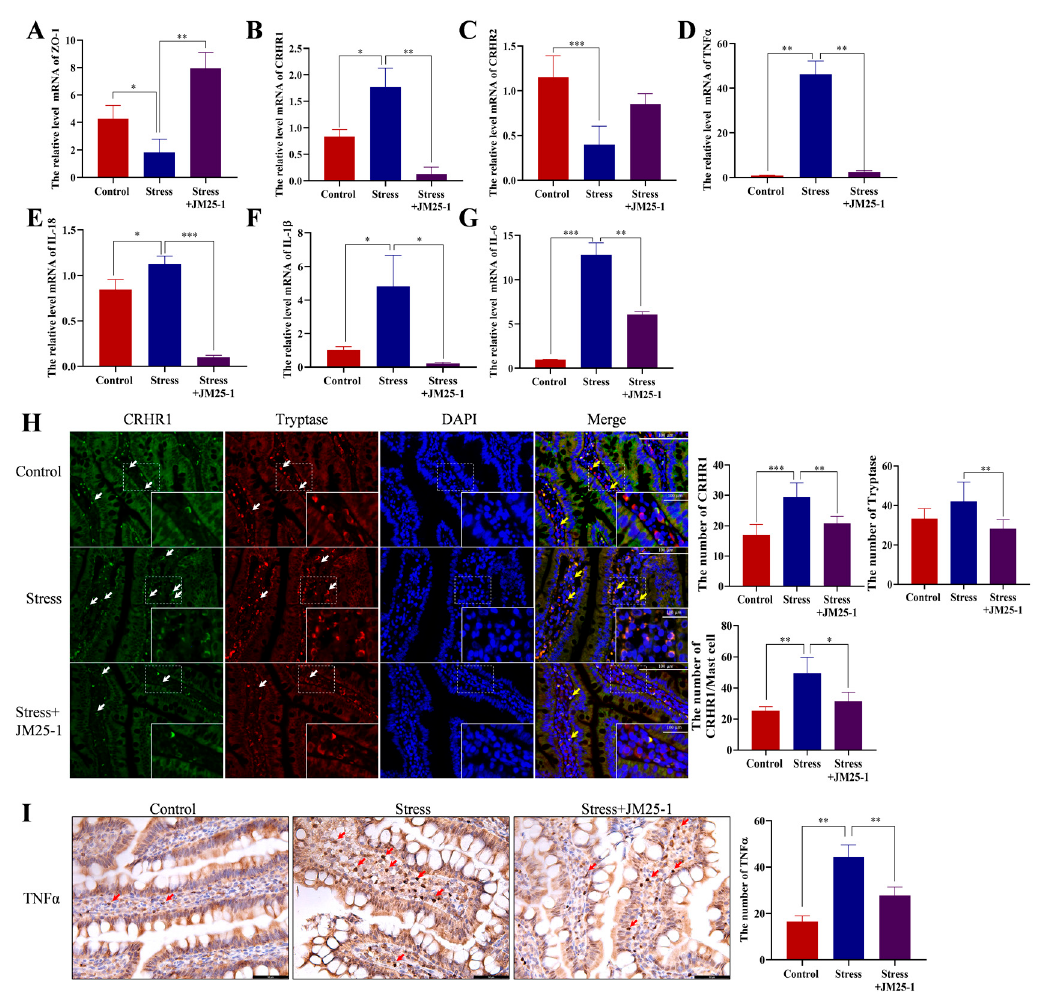
Figure 5. Effect of JM25-1 on the expression of CRH receptors and cytokines in small intestine of stress-induced rats. The relative expression of related mRNA in small intestine of stress-induced rats for ( A ) ZO-1, ( B ) CRHR1, ( C ) CRHR2, ( D ) TNF α , ( E ) IL-18, ( F ) IL-1 β and ( G ) IL-6. The data are repeated in at least three independent experiments in triplicate compared with Control group. Bars, S.D. * p ≤ 0.05, ** p ≤ 0.01, *** p ≤ 0.001. ( H ) The immunofluorescence staining of CRHR1 in Tryptase-labeled MC. The white arrows indicate representative CRHR1, Tryptase positive cells, respectively. Yellow arrows indicate the cells with FITC-CRHR1 located HRP-Tryptase. Magnification: 400× and 800×. Scale bar: 100 μ m. Bar chart indicates the number of CRHR1, Tryptase labeled MC and CRHR1 to MC; bars, S.D. * p ≤ 0.05, ** p ≤ 0.01. ( I ) The immunohistochemistry staining of TNF α in small intestine. Red arrows indicate distribution of TNF α . Magnification: 400×. Scale bar: 50 μ m. Bars, S.D. ** p ≤ 0.01.